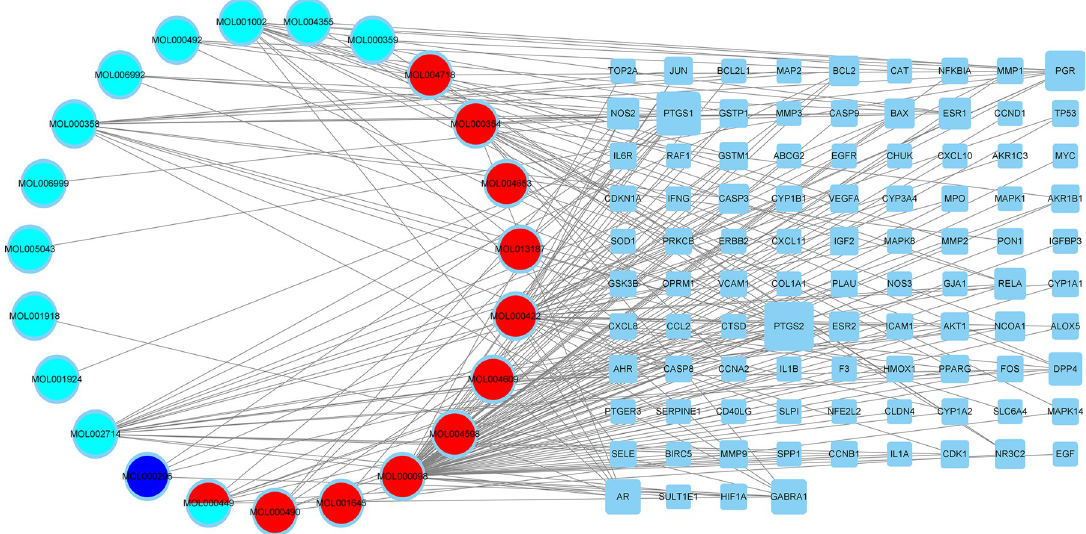
Fig 3. The drug-target interaction pharmacology network. Circles represent the small molecule active compounds in QUF (red: Radix Bupleuri; blue: Curcumae Rhizoma; aqua: Radix Paeoniae Rubra). Rounded rectangles represent endometriosis-related target genes, and edges represent the interaction between small molecule compounds and target